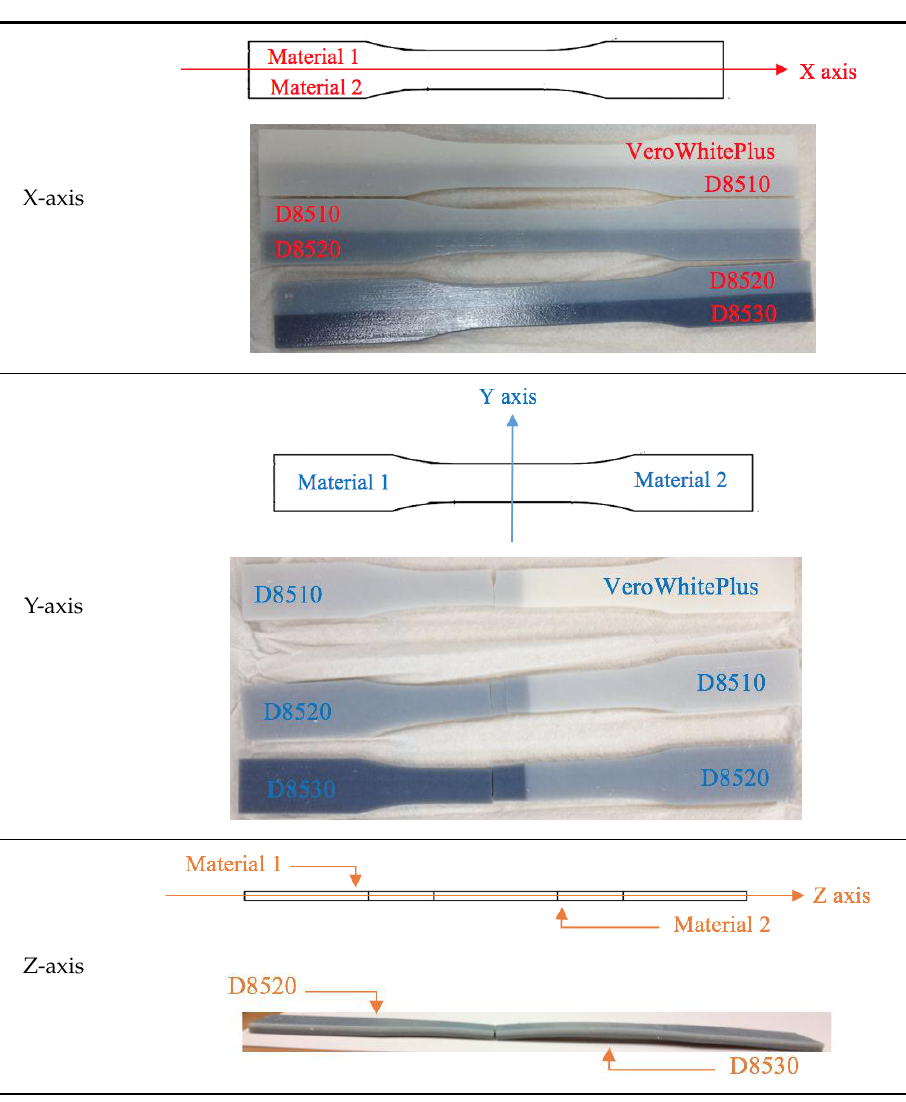
Table 2. Specimen material composition.